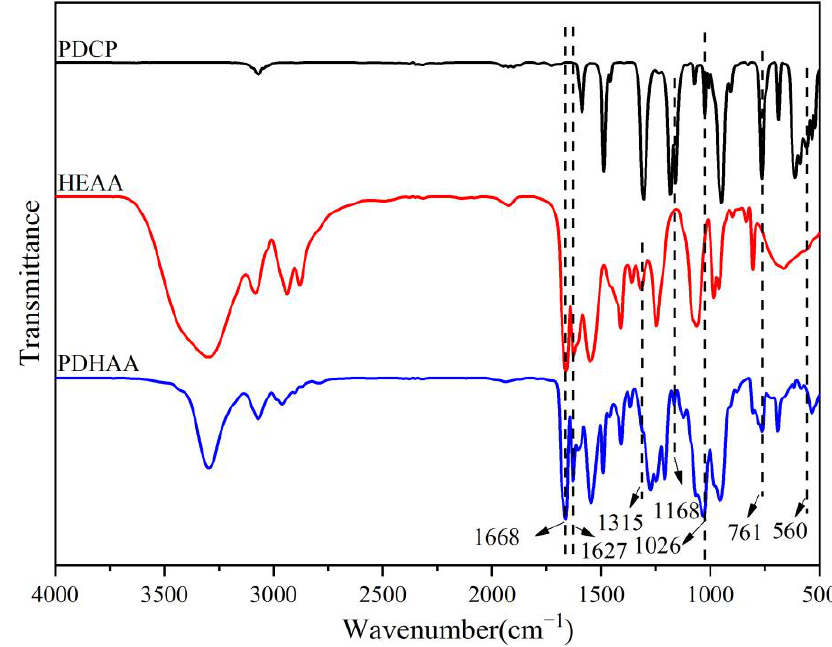
Figure 2. FTIR spectrum of PDCP, HEAA, and PDHAA.